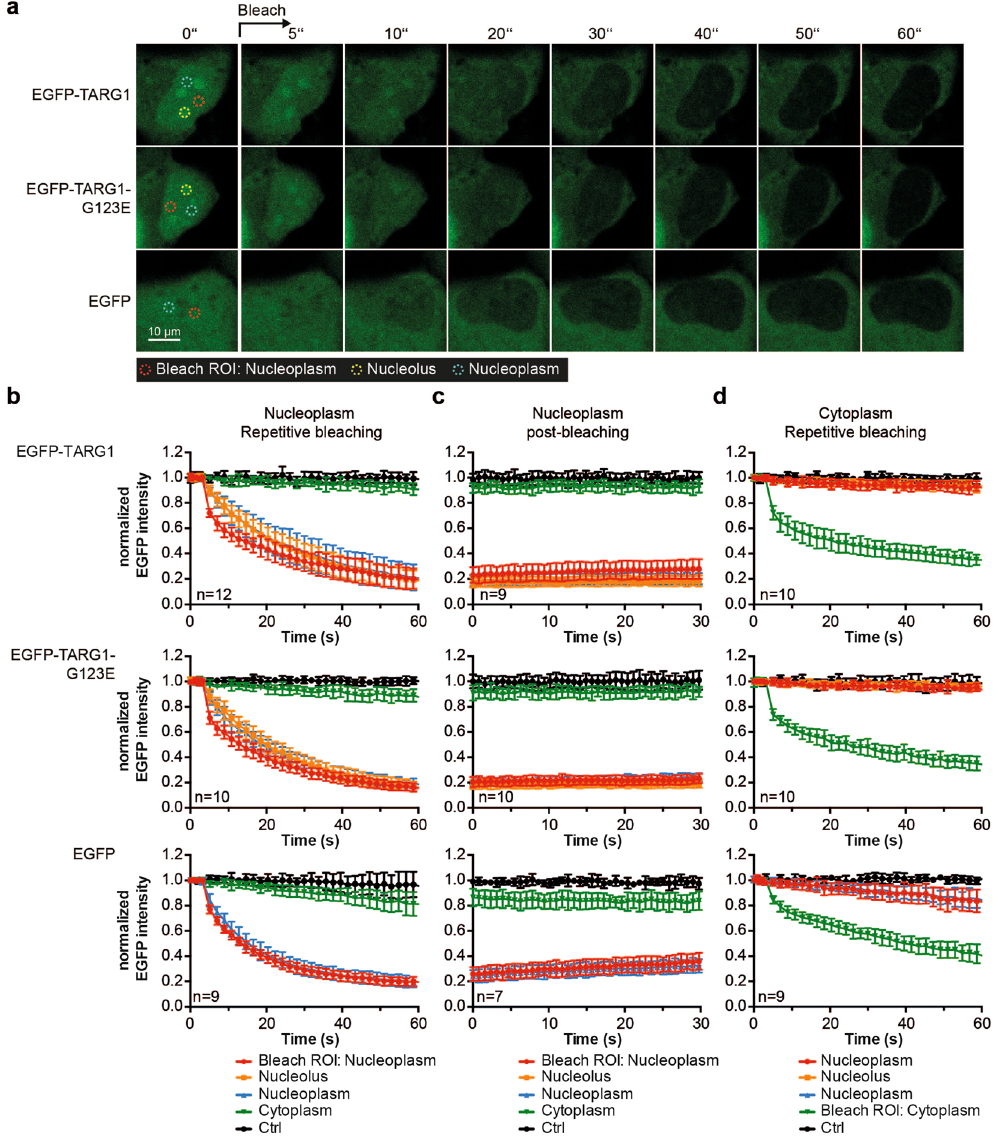
Figure 4. EGFP-TARG1 rapidly shuttles between the nucleoplasmic and the nucleolar compartment. ( a ) Fluorescence loss in photo-bleaching (FLIP) experiments in U2OS cells transiently expressing EGFP-TARG1, EGFP-TARG1-G123E or EGFP. mCherry-H2B was co-expressed to define the nucleoplasm (not shown). Representative images are shown. ( b–d ) EGFP fluorescence intensities of EGFP-TARG1 (upper panels), EGFP- TARG1-G123E (middle panels) and EGFP (lower panels) were measured in each ROI during photo-bleaching of nucleoplasmic EGFP ( b ), after total photo-bleaching of nucleoplasmic EGFP ( c ) or during photo-bleaching of cytoplasmic EGFP ( d ). Fluorescence intensities were normalized to the mean EGFP fluorescence intensity in the same ROI before bleaching and are expressed as mean ± SD of 7–12 cells as